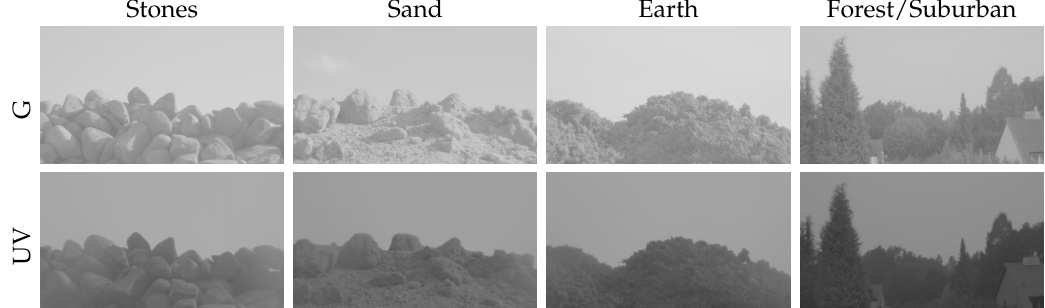
Figure 5. Examples of captured HDR images with our camera setup taken at 17:00 for both the UV and green channel. The first three columns show different mineral skylines (stones, sand, earth), while the last column shows a skyline in a suburban area of Bielefeld (forest/suburban).